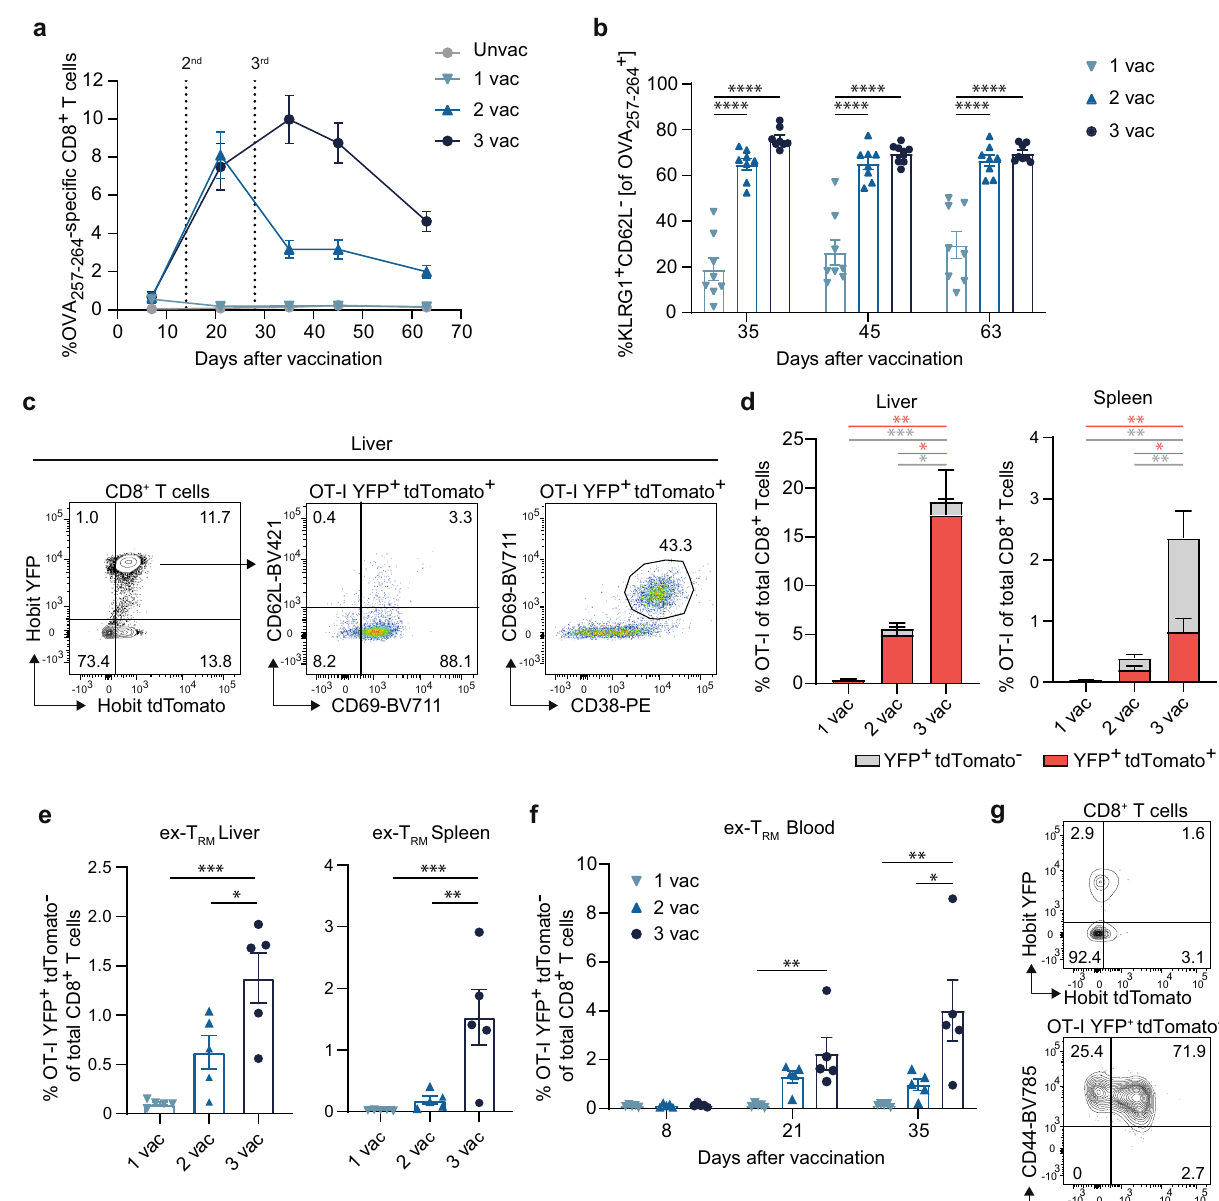
Fig. 5 A third vaccination triggers the remigration of T RM cells into the circulation. a C57BL/6 mice were vaccinated with the T cell OVA 257-264 -SLP vaccine adjuvanted with CpG in a prime-boost-boost regimen with 2 week intervals. Shown are the OVA 257-264 -speci fi c CD8 + T cell kinetics in blood at indicated days after vaccination. Data is represented as mean ± SEM ( n = 8 per group). b Frequencies of KLRG1 + CD62L − OVA 257-264 -speci fi c CD8 + T cells in blood in time. Data represented as mean ± SEM ( n = 8 per group). Symbols represent individual mice. **** P = < 0.0001. c – g 1 × 10 4 OT-I Hobit LT CD8 + T cells were adoptively transferred into C57BL/6 mice. The day after, mice received the fi rst OVA 257-264 -SLP vaccination, followed by 2 boosters. After 50 days spleen and liver were analyzed by fl ow cytometry. c Flow cytometry plots showing the CD62L, CD69, and CD38 expression of liver OT-I YFP + tdTomato + CD8 + T cells. d Percentage of OT-I YFP and/or tdTomato positive CD8 + T cells in liver and spleen. Data is represented as mean + SEM ( n = 5 per group). * P = 0.0144 – 0.0267, ** P = 0.0025-0.0089, *** P = 0.0007. e Percentage of OT-I YFP + tdTomato − (ex-T RM ) of total CD8 + T cells in liver and spleen. Data represented as mean ± SEM ( n = 5 per group). Symbols represent individual mice. * P = 0.0267, **P = 0.0040 – 0.0089, *** P = 0.00070082. f Percentage of OT-I Hobit YFP + tdTomato − (ex-T RM ) cells of total CD8 + T cells in blood. Data represented as mean ± SEM ( n = 5 per group). Symbols represent individual mice. * P = 0.0327, ** P = 0.0076 – 0.0082. g Phenotype of OT-I YFP + tdTomato − (ex-T RM ) CD8 + T cells in the spleen. One-way ANOVA with Tukey ’ s multiple comparison test for ( a , d – f ). Source data are provided as a Source Data fi le. Methods were previously described 32 . At the start of the experiments, male and female mice Mice . Wild-type C57BL/6 mice were obtained from Charles River Laboratories, were 6-8 weeks old. Animals were housed in individually ventilated cages under speci fi c-pathogen-free conditions at the animal facility at the Leiden University Jackson Laboratory, or Janvier Labs. The K18-hACE2 transgenic mice, expressing Medical Center (LUMC) at 20 – 22°C, a humidity of 45 – 65% RV, and a light cycle the human ACE2 receptor (hACE2) under control of the cytokeratin 18 (K18) of 6:30h – 7:00h sunrise, 07:00 h – 18:00 h daytime and 18:00 h – 18:30 h sunset. All promoter 41 , were obtained from the Jackson Laboratory (B6.Cg-Tg(K18-ACE2) animal experiments were approved by the national Central Animal Testing 2Prlmn/J), and bred in-house. The Hobit reporter OT-I × ROSA26-eYFP mice NATURE COMMUNICATIONS| (2022) 13:3966